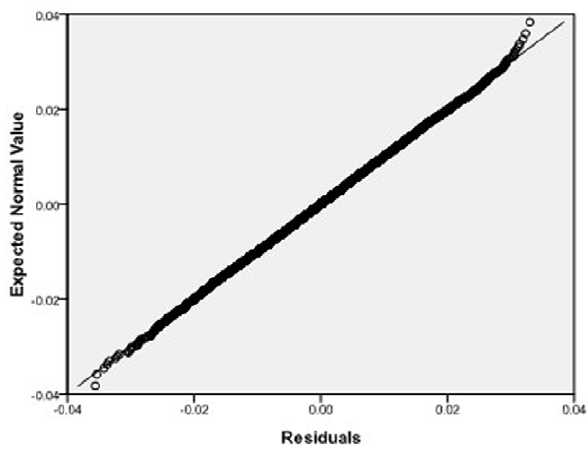
Figure 5. Histogram and asymptotic distribution for ^ bb 1 of GLS when the variance function of the error term is s 2 ( x 1 , x 2 ) ~ exp ( { ( x 1 z x 2 )) .